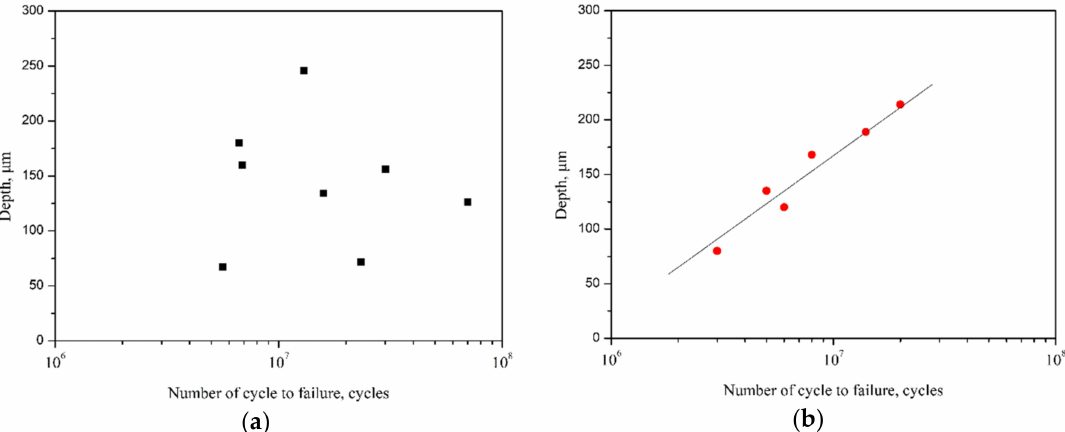
Figure 12. Relationship between the crack initiation site depth and the number of cycles to failure: ( a ) smooth specimens, and ( b ) notched